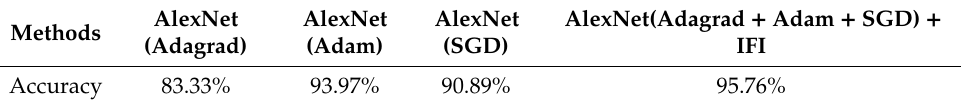
Table 10. Recognition results of AlexNet architectures with di ff erent optimization method.